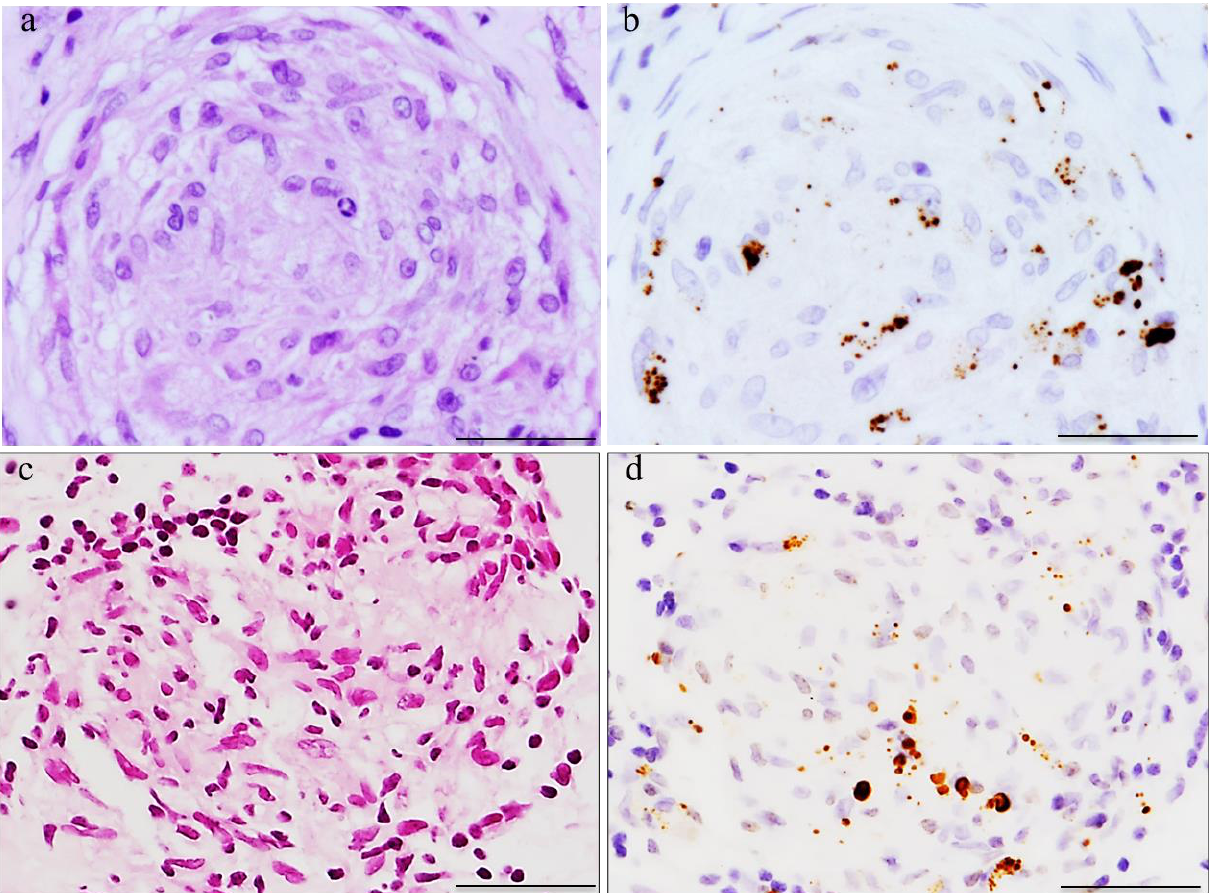
Figure 1. Immunohistochemical localization of C. acnes in sarcoid granulomas. Hematoxylin–eosin stain and immunohistochemistry with the C. acnes -specific PAB antibody are shown pairwise. Mainly small round and occasionally large ovoid PAB antibody-positive signals can be observed in non-caseating epithelioid cell granulomas of the lung ( a , b ) and ocular epiretinal membrane ( c , d ) from patients with sarcoidosis irrespective of the sites at which the granuloma formed. All photos are original and were previously published [35] . Scale bar: 50 μm.